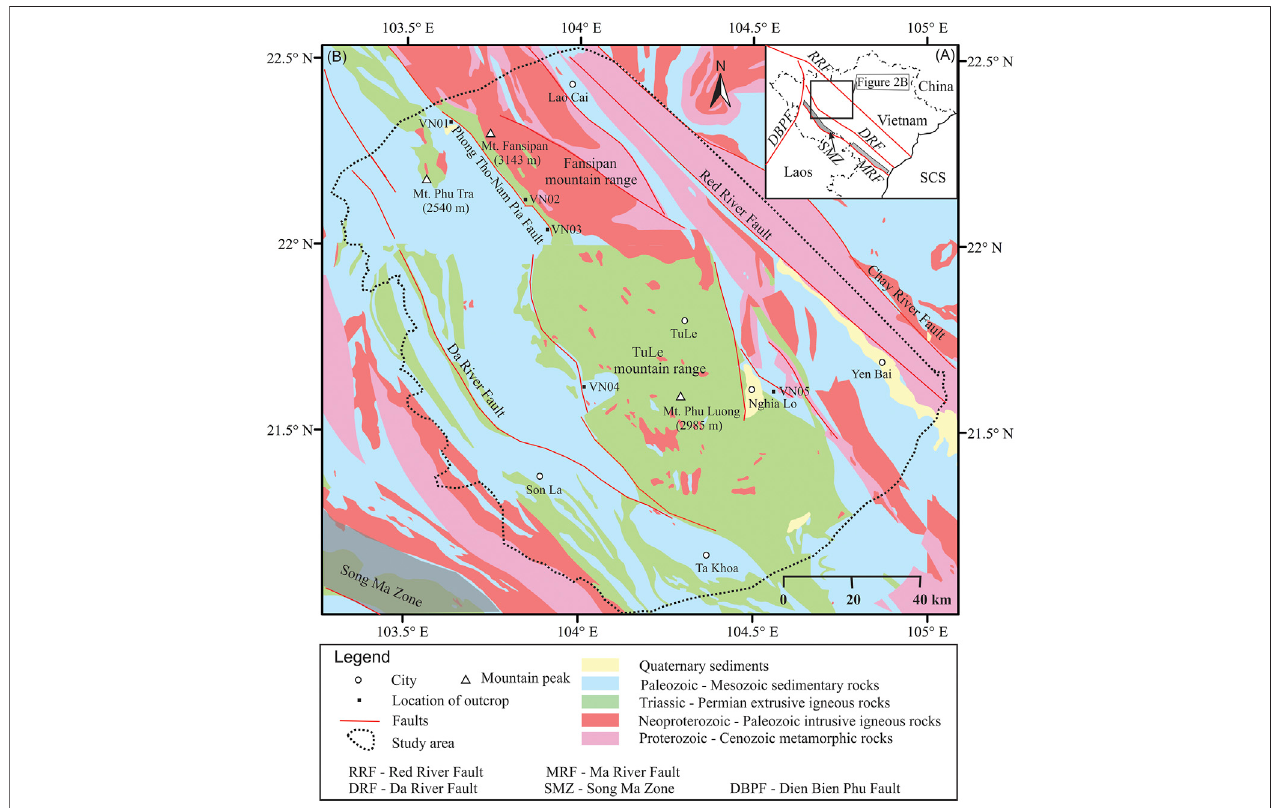
FIGURE2|(A) TectonicmapofnorthernVietnamshowingdistributionofthemajorstructuresandfaults:SMZ-SongMaZone,MRF-MaRiverFault,DRF-DaRiver Fault, RRF- Red River Fault, and DBPF- Dien Bien Phu Fault; (B) Simpli fi ed geological map within and surrounding the Fansipan and Tule mountain ranges, northern Vietnam (After 1: 1,500,000 geological map, General Geological Department of Vietnam, 1983). Red solid line presents fault. Dashed polygon indicates the study area.